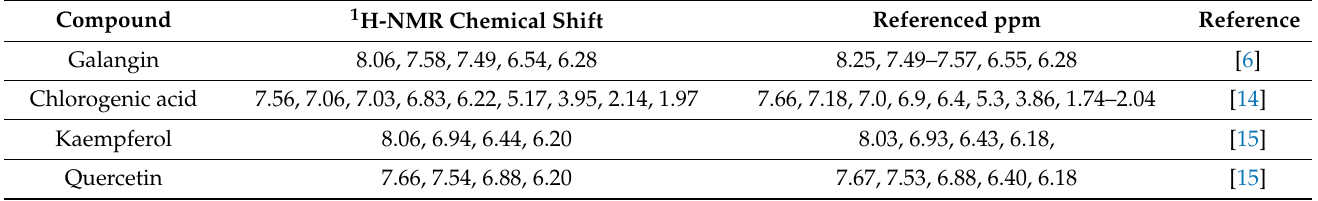
Table 4. The 1 H NMR peaks (ppm) of annotated compounds that contributed to the observed separation of extracts collected from Wakefield in both seasons relative to the Telperion collections across both